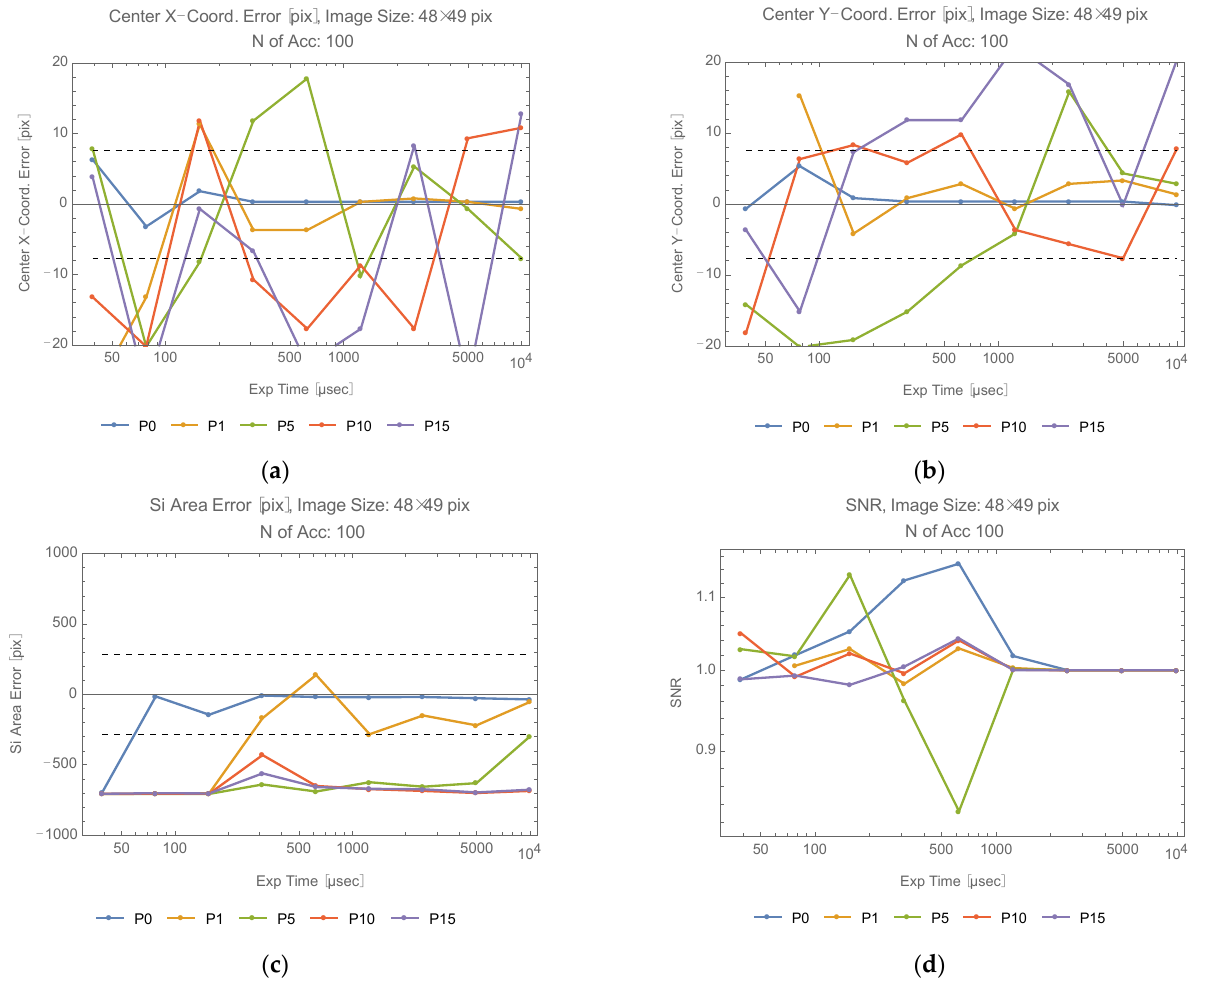
Figure A8. Center coordinate error, area error, SNR (100 accumulation): ( a ) Center X-coordinate error; ( b ) Center Y-coordinate error; ( c ) Si area error; ( d ) SNR.